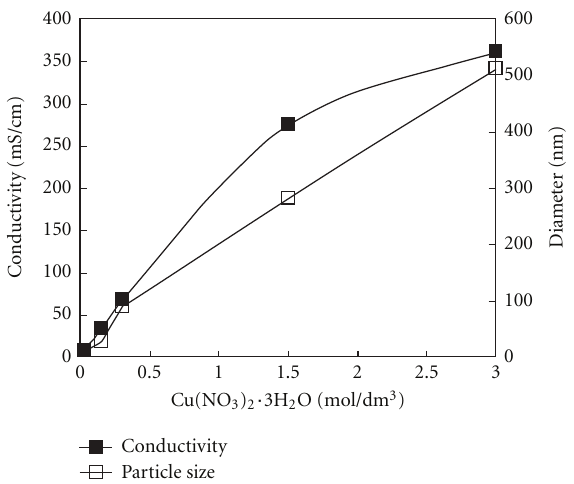
Figure 3: Conductivity and particle diameter as a function of sur- factant concentration at 0.3 mol/dm 3 of Cu(NO 3 ) 2 · 3H 2 O.